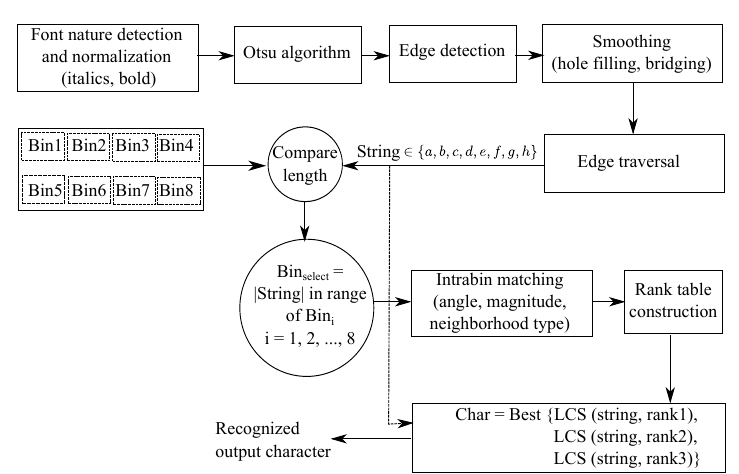
Figure 2. Overall block diagram of the proposed scheme.